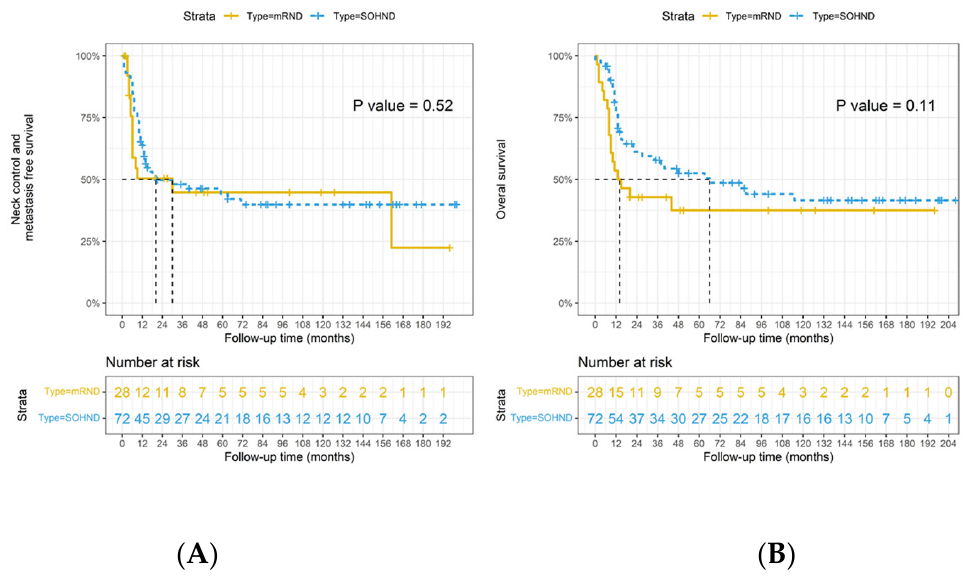
Figure 2. ( A ) Disease-free survival differences in multiple nodal disease by types of neck dissection (n =100, p = 0.52); ( B ) overall survival differences in multiple nodal disease by types of neck dissection ( p = 0.11). Neck-control-distant metastases-free survival in multiple nodal disease by types of neck dissection. Dotted line indicated the survival time that half of the patients had no events.